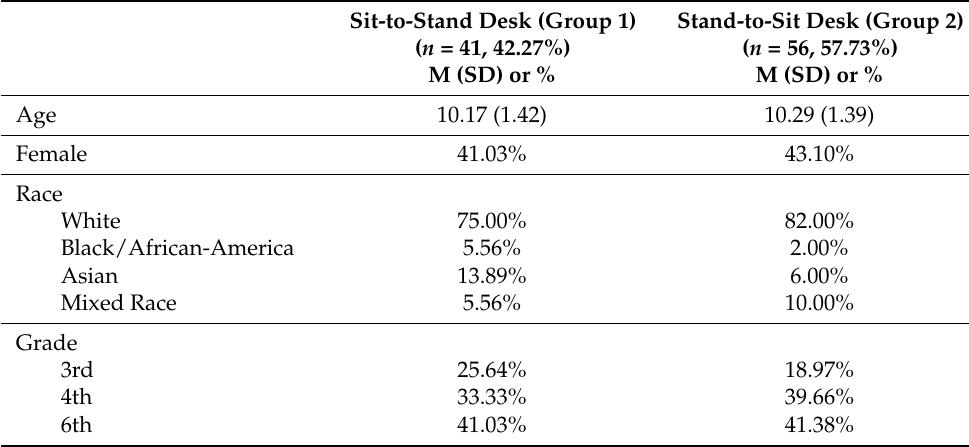
Table 1. Baseline Mean Cognitive and Behavioral Ratings. Sit-to-Stand Desk (Group 1)